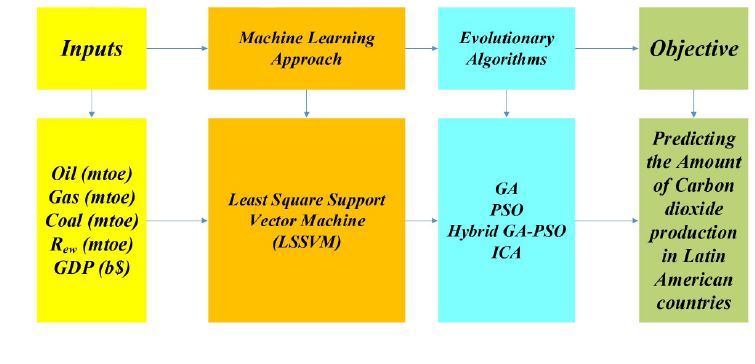
Figure 5. Schematic diagram of the employed methodology to predict the amount of produced carbon dioxide in Latin American countries (mtoe: million tons oil equivalent; b$: billion